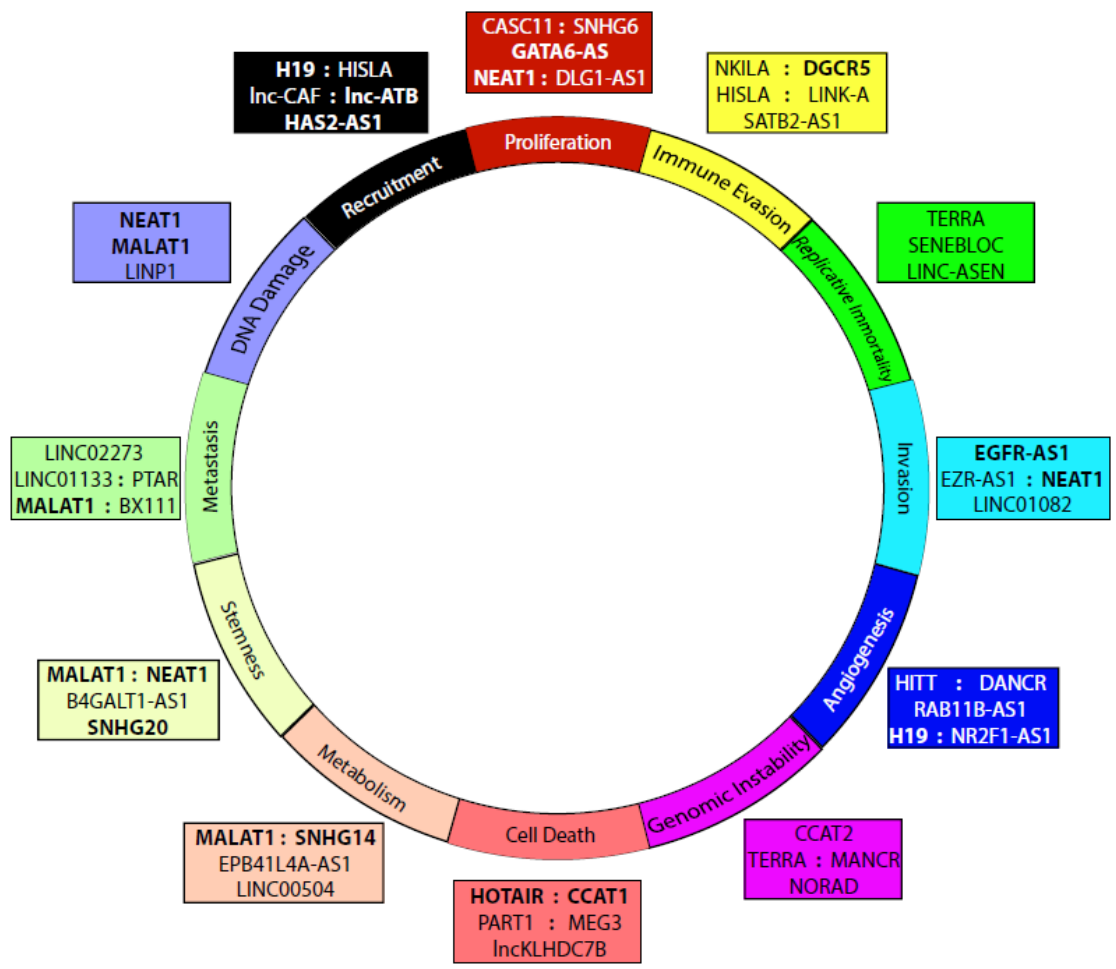
Figure 2. Hallmark characteristics of cancer are regulated by lncRNAs. Colored boxes contain lncRNAs functionally linked to regulation of the corresponding cancer hallmark. Recruitment refers to the recruitment or association with stromal cells. LncRNAs with known association to gliomas are highlighted in bold (Discussed in Section 5).